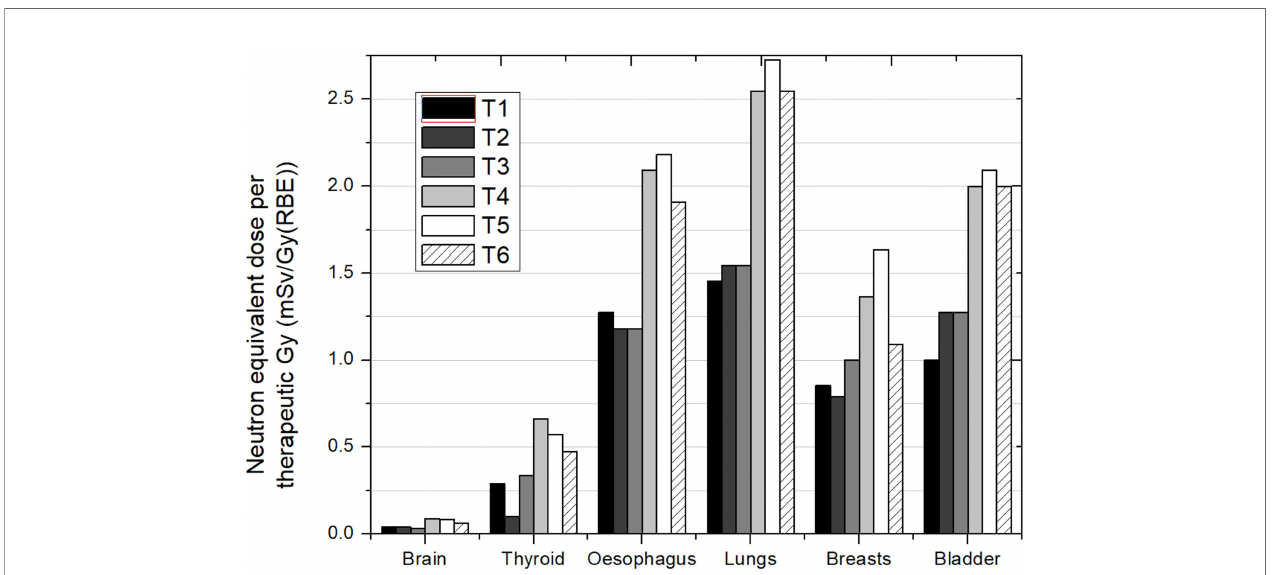
FIGURE 5 | Neutron equivalent doses per therapeutic Gy in selected organs for the 6 different spinal fi elds in the same passive scattering proton beam facility. T1 (aperture diameter = 3 cm), T2 (aperture diameter = 6 cm), and T3 (aperture diameter = 9 cm) had a range and a modulation width of 10 and 5 cm, respectively. T4 (aperture diameter = 3 cm), T5 (aperture diameter = 6 cm) and T6 (aperture diameter = 9 cm) had a range and a modulation width of 15 and 10 cm, respectively. Data extracted from Athar and Paganetti